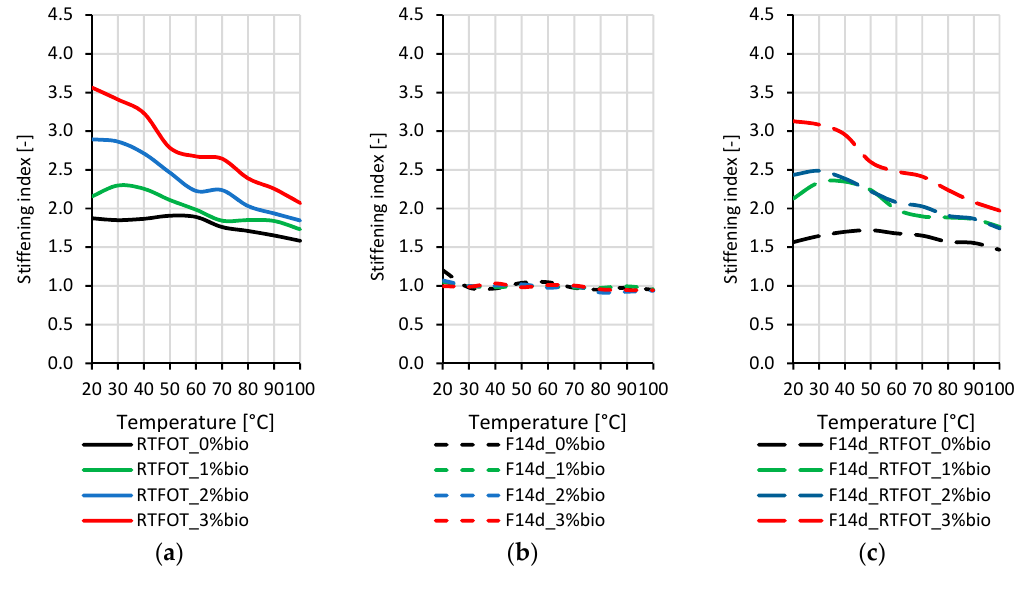
Figure 8. Stiffening index of the 45/80–55 polymer-modified bitumen: ( a ) non-foamed after RTFOT ageing bitumen (RTFOT); ( b ) foamed original bitumen (F14d); ( c ) foamed after RTFOT ageing bitumen (F14d_RTFOT).